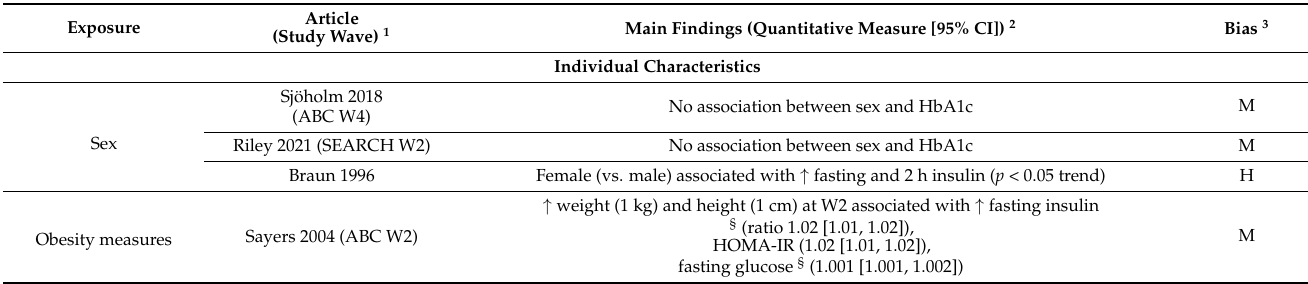
Table 6. Quantitative associations with glucose, insulin and diabetes outcomes, arranged by exposure type and listed in order of lowest to highest risk of